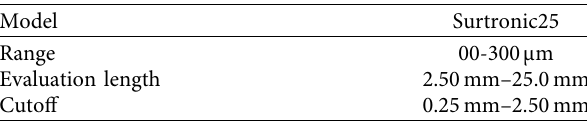
Table 3: Input parameters and their levels.